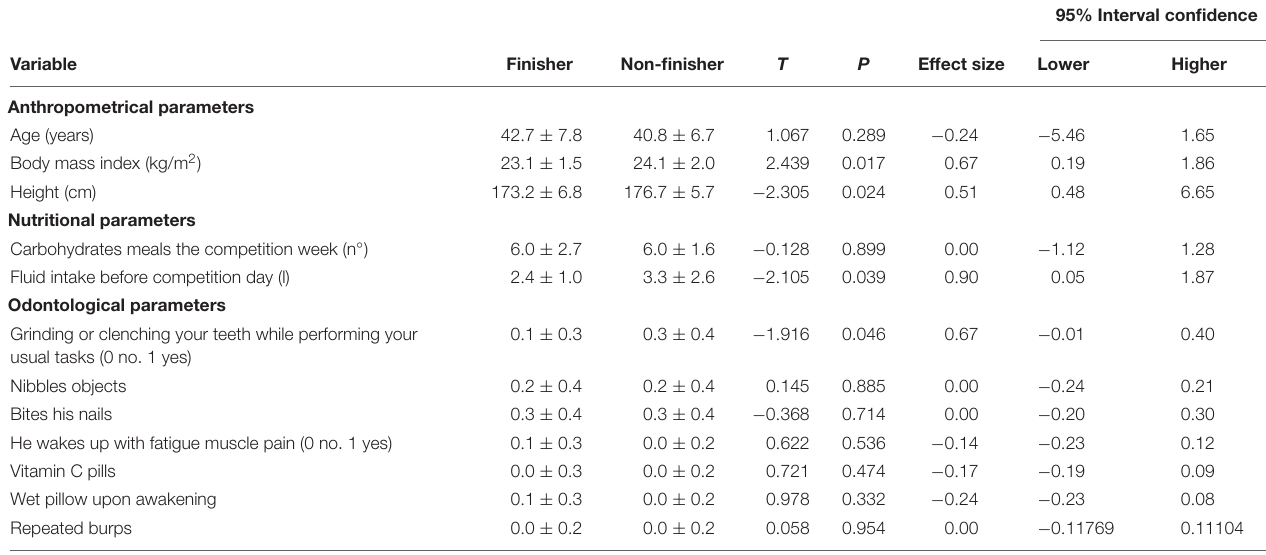
TABLE 3 | Differences between mountain ultra-endurance finishers and non-finishers in anthropometrical, nutritional and odontological parameters.